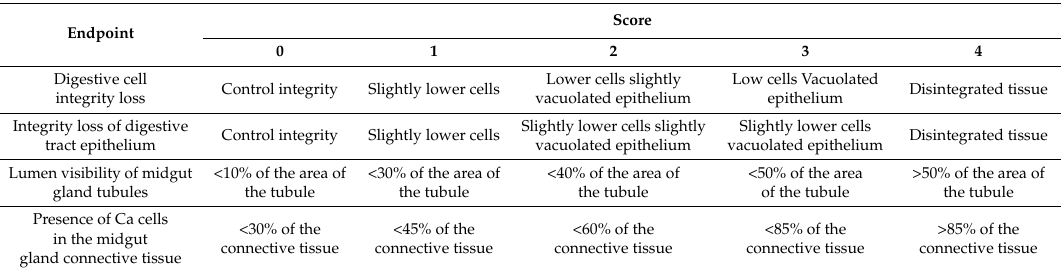
Table 1. Criteria for the semi-quantification of the histopathological alterations observed in the midgut gland of Littorina littorea upon Cd exposure: Digestive cell integrity loss, Integrity loss of digestive tract epithelium, Lumen visibility of midgut gland tubules, Presence of Ca cells in midgut gland connective tissue. The appraisal of the apparent histopathological status is ranked in arbitrary units from 0 to 4, with 0 being the control value and 4 the worst possible